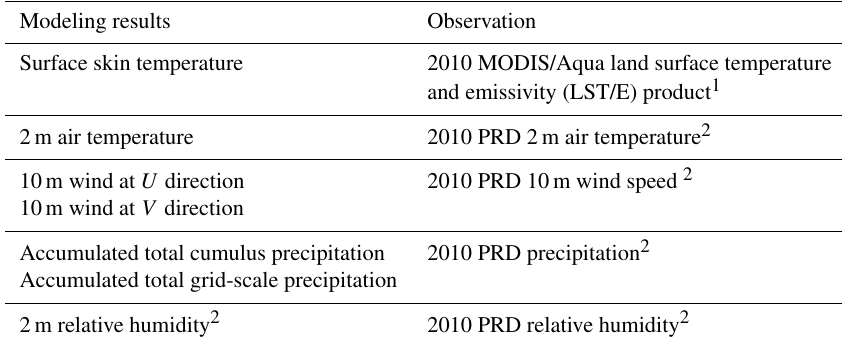
Table 1. Comparative meteorological variables.